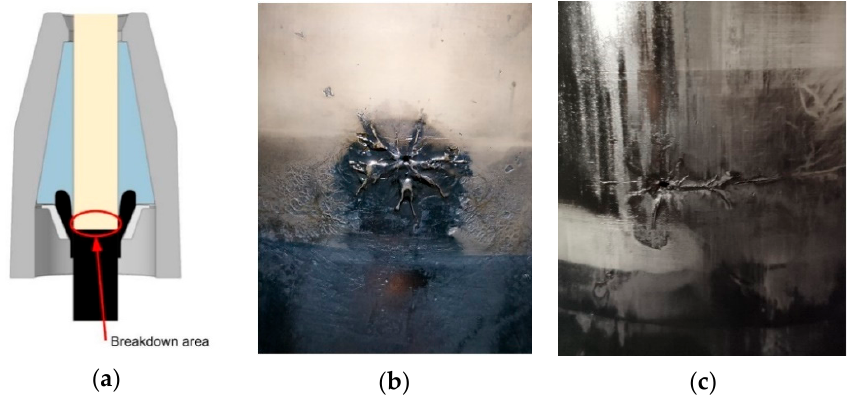
Figure 5. The breakdown area was concentrated on the interface between the cable insulation and the semi-conductive deflector, as shown in ( a ). The pictures of the punctured cable surface are presented: ( b ) breakdown point on the cable side without visible creepage trace; ( c ) breakdown point with a short creepage trace to the right.